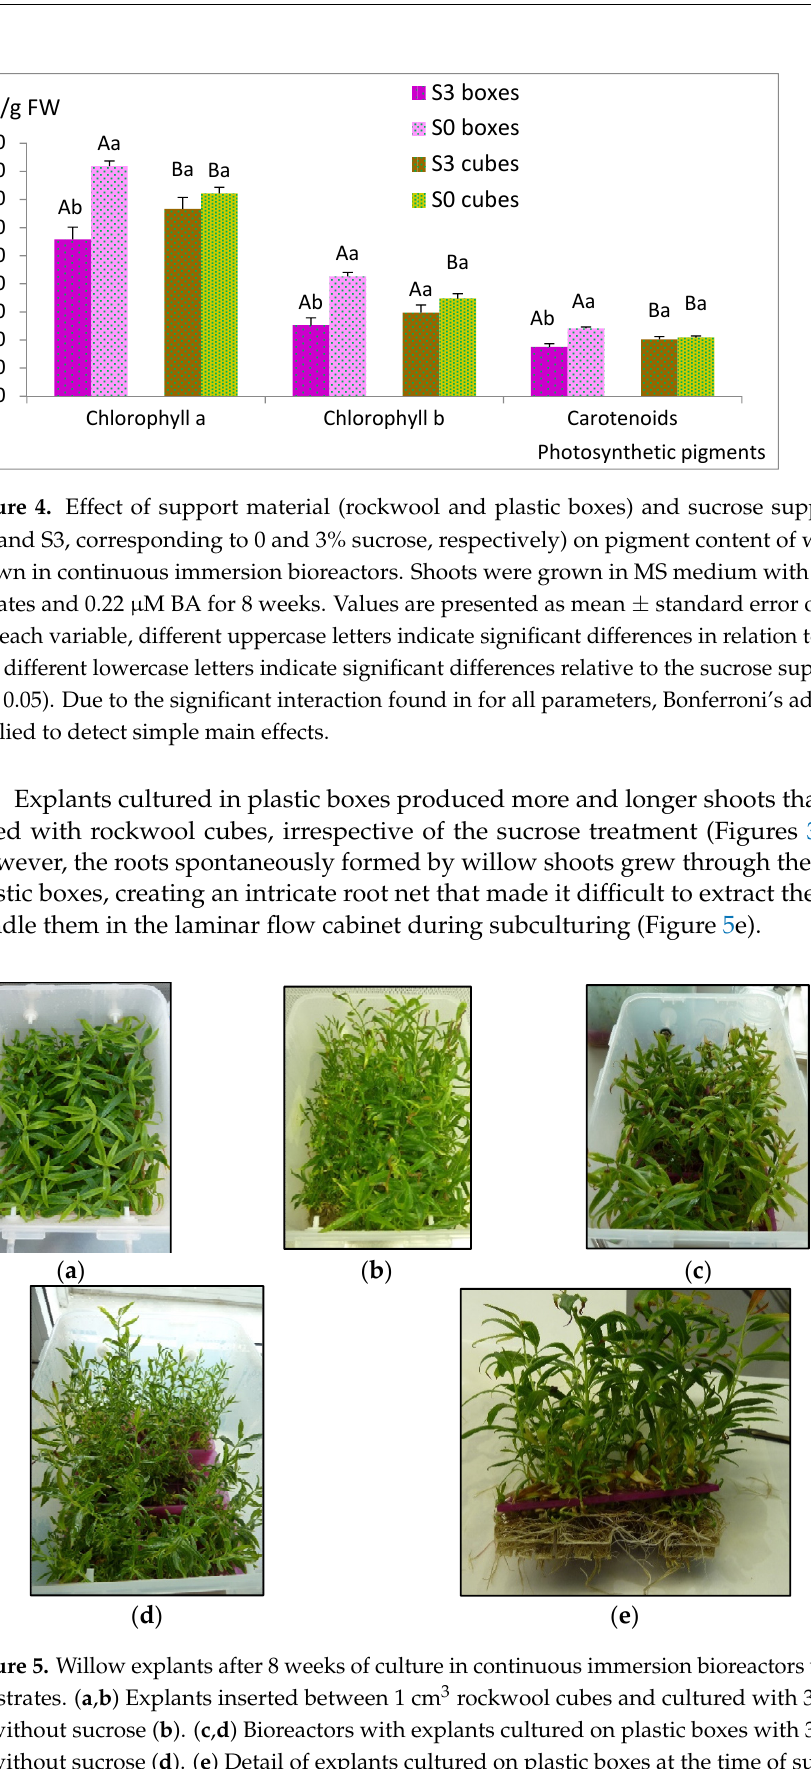
Figure 5. Willow explants after 8 weeks of culture in continuous immersion bioreactors with different substrates. ( a , b ) Explants inserted between 1 cm 3 rockwool cubes and cultured with 3% sucrose ( a ) or without sucrose ( b ). ( c , d ) Bioreactors with explants cultured on plastic boxes with 3% sucrose ( c ) or without sucrose ( d ). ( e ) Detail of explants cultured on plastic boxes at the time of